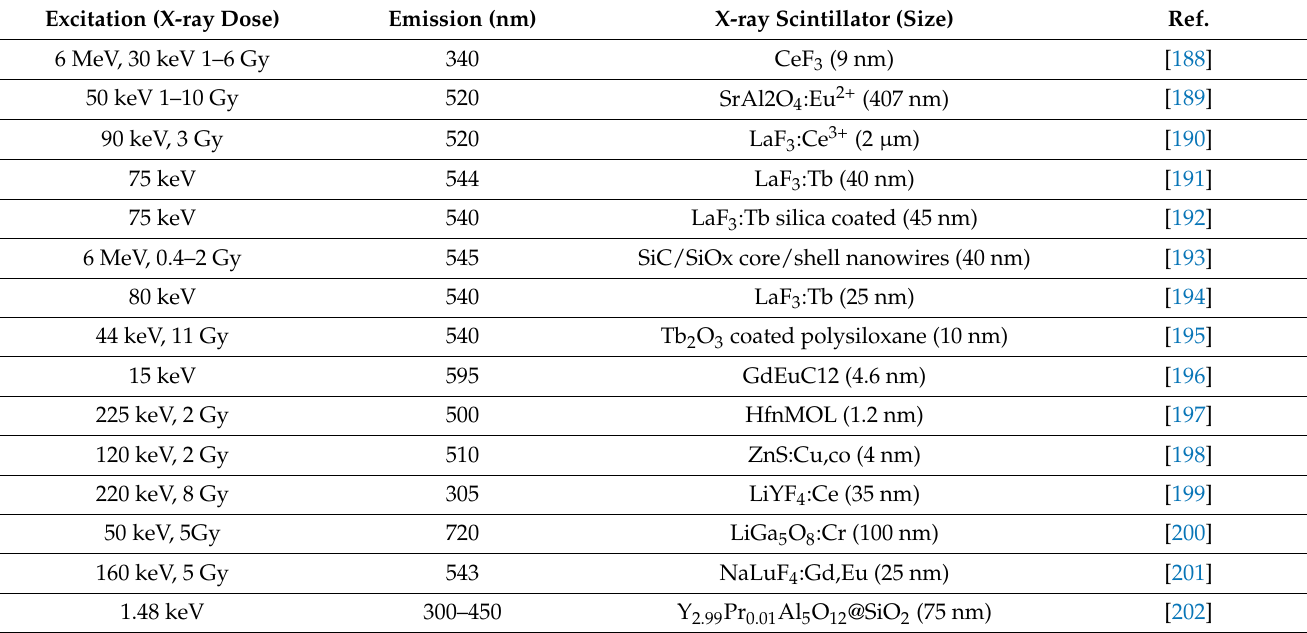
Table 4. Some reported X-ray SCNPs with the required energy to activate them and the emission wavelengths. Adapted with permission from